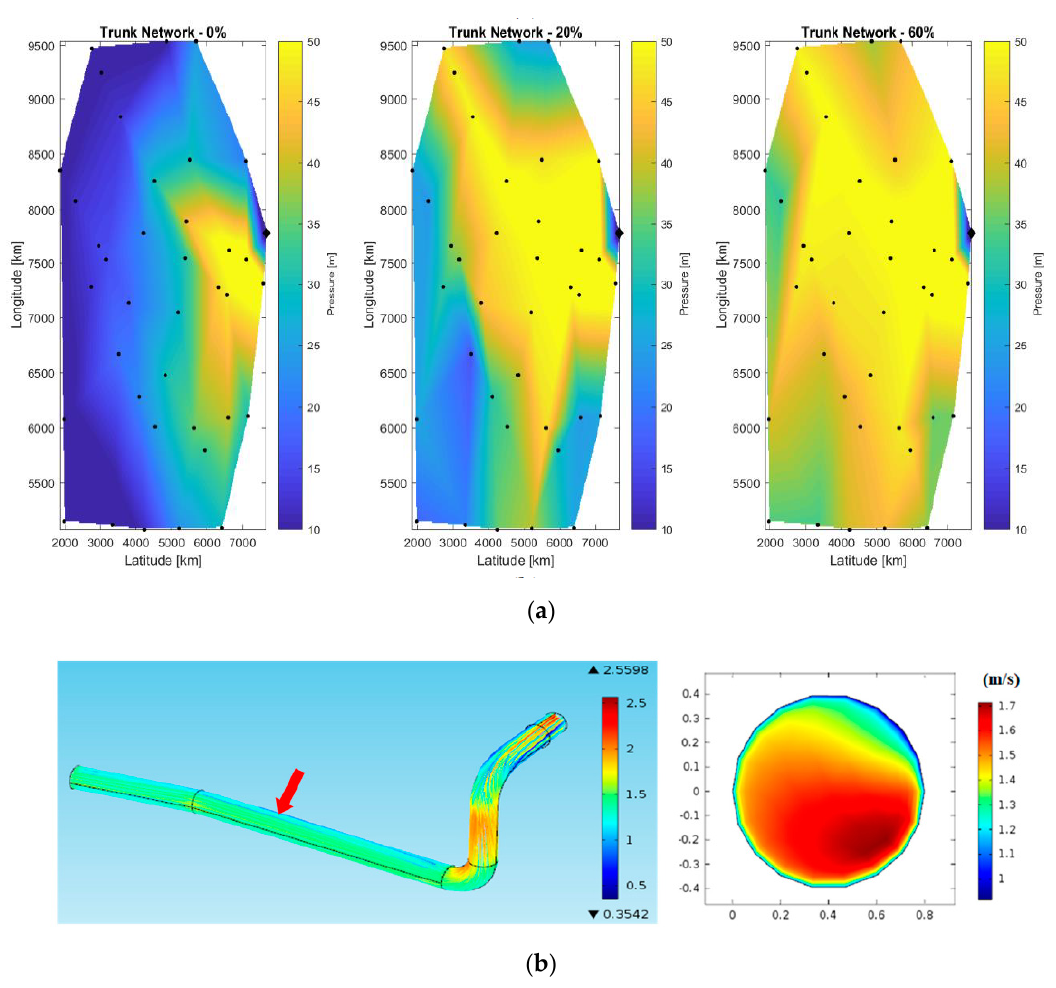
Figure 2. Pressure zones for the initial scenario and for trunk mains with 20% and 60% of the pipes with bigger diameters and a pipe burst ( a ); and streamlines and velocity distribution in the cross section of a pipe ( b ).